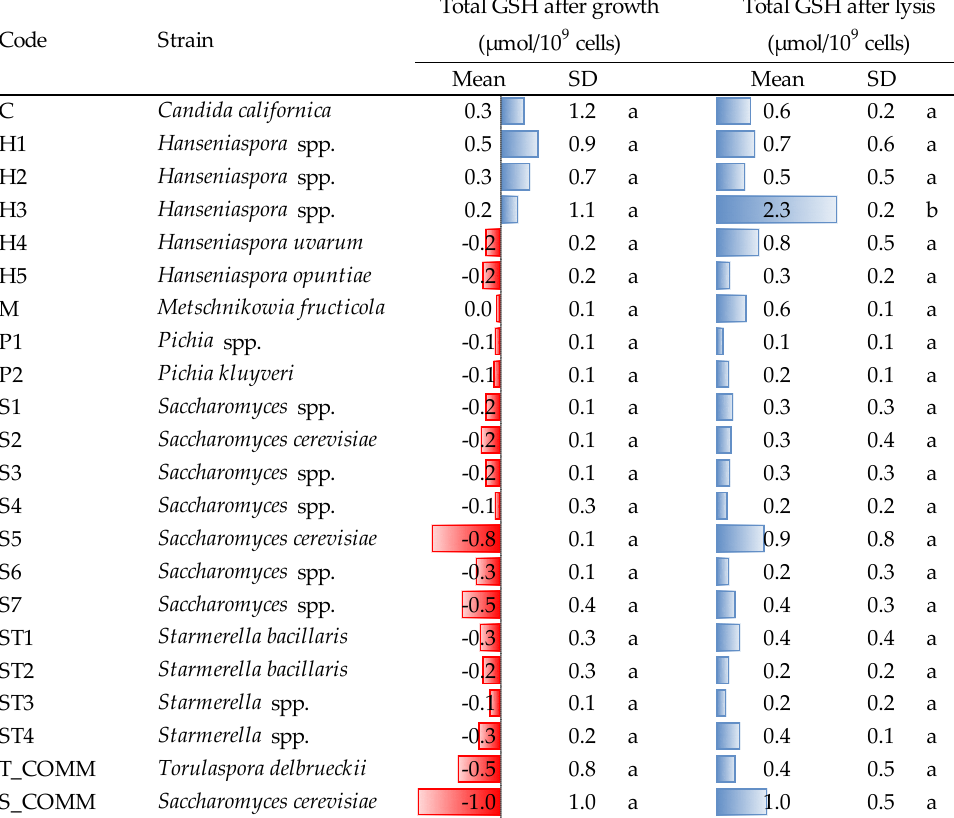
Figure 5. Amount of glutathione released by the different strains after growth (48 h, YPD medium, 30 °C) and after lysis induced by β -glucanase enzymes. Data are means and standard deviations (SD) of three repetitions. Different letters mark significant differences according to ANOVA and Tukey HSD test at p < 0.05. T_COMM, S_COMM: commercial active dry yeast preparations. Concerning the values detected after growth, positive and negative values (blue and red bars) indicate, respectively, an increase/production or a decrease/consumption, with respect to the initial composition of the YPD medium.